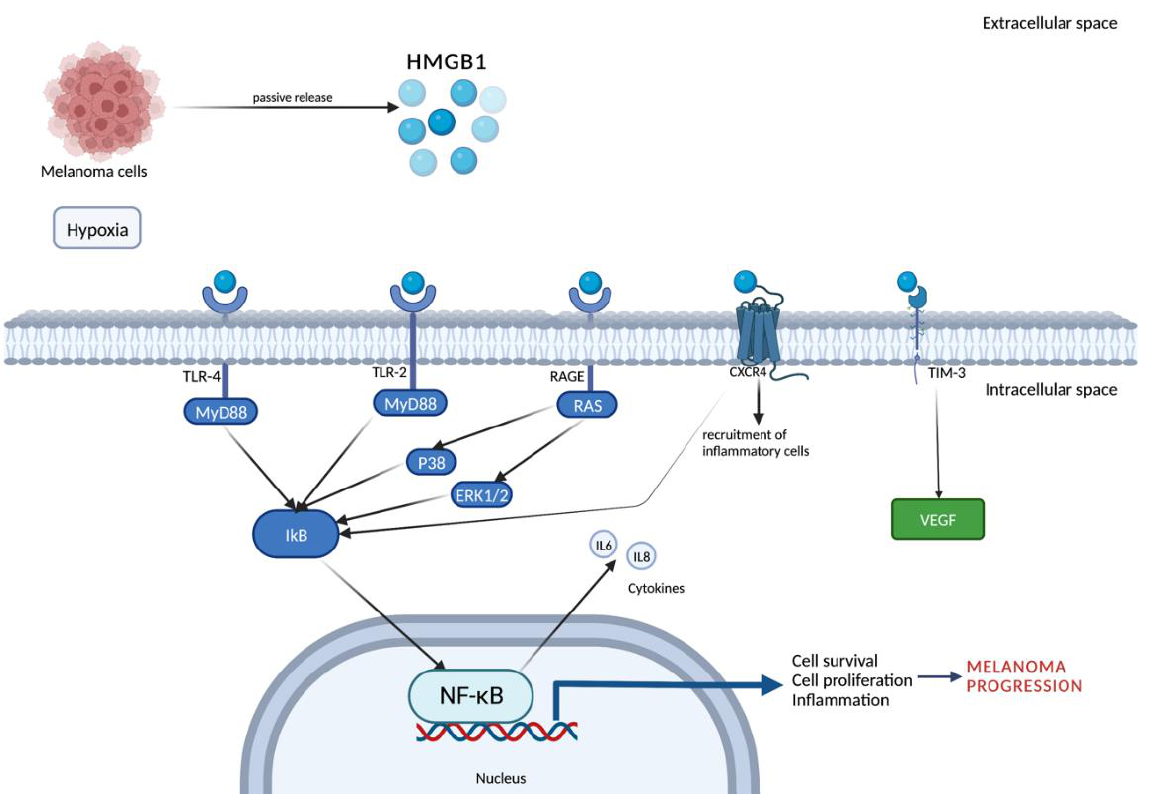
Figure 2. HMGB1 is released into the extracellular environment through a passive mechanism by melanoma cells. HMGB1 binds to RAGE, TLR2, and TLR4 and transduces cellular signals through a common pathway that induces the NF- κ B pathway. The activated NF- κ B translocates to the nucleus. HMGB1 also interacts with CXCR4 to activate the NF- κ B pathway and induce chemotaxis and recruitment of inflammatory cells. The interaction of HMGB1 and TIM-3 induces the secretion of VEGF to promote tumor angiogenesis. All these pathways promote cell survival, cell proliferation and, finally, melanoma progression. Created with BioRender.com.